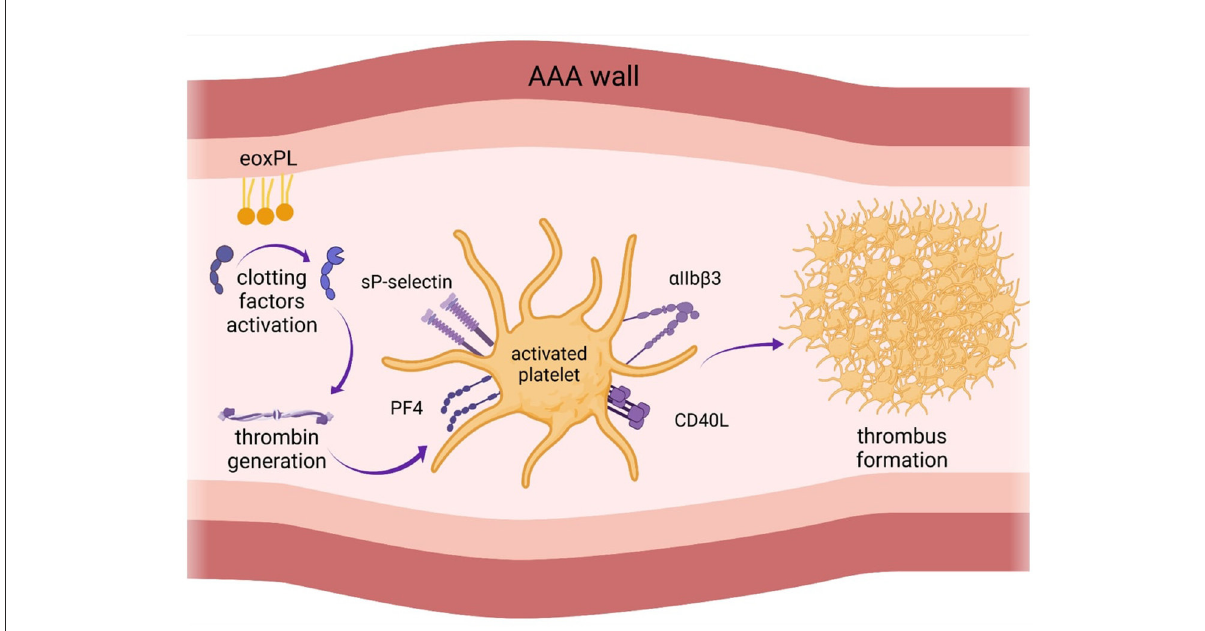
FIGURE2 Changes in platelet function after endovascular aortic aneurysm repair (EVAR). There is consensus that platelet count decreases shortly after EVAR. However, evidence regarding the effect of EVAR on platelet activation remains contradictory. AAA, abdominal aortic